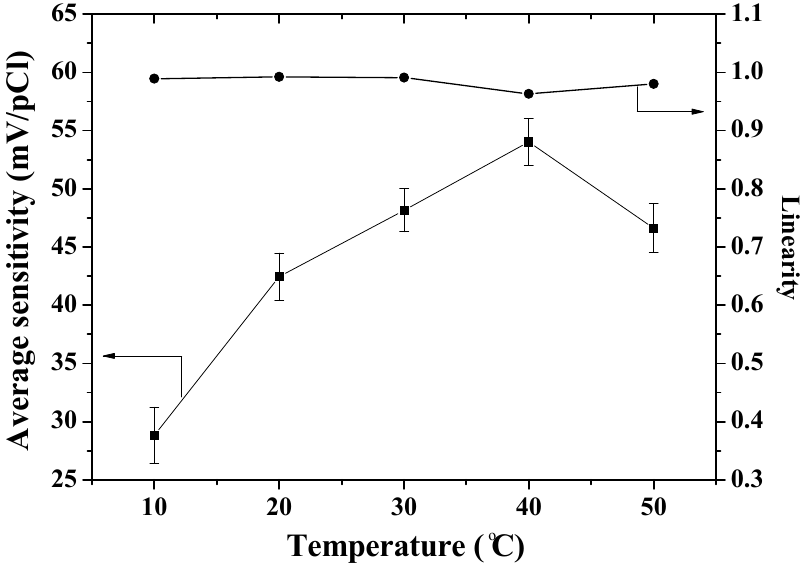
Figure 6. The average sensitivities and linearities of the different temperatures for the arrayed flexible RuO 2 /GO chloride sensor. Table 2. Comparison of the sensitivities of PET/RuO 2 /GO and PET/RuO 2 [37] chloride sensor at different solution temperatures.